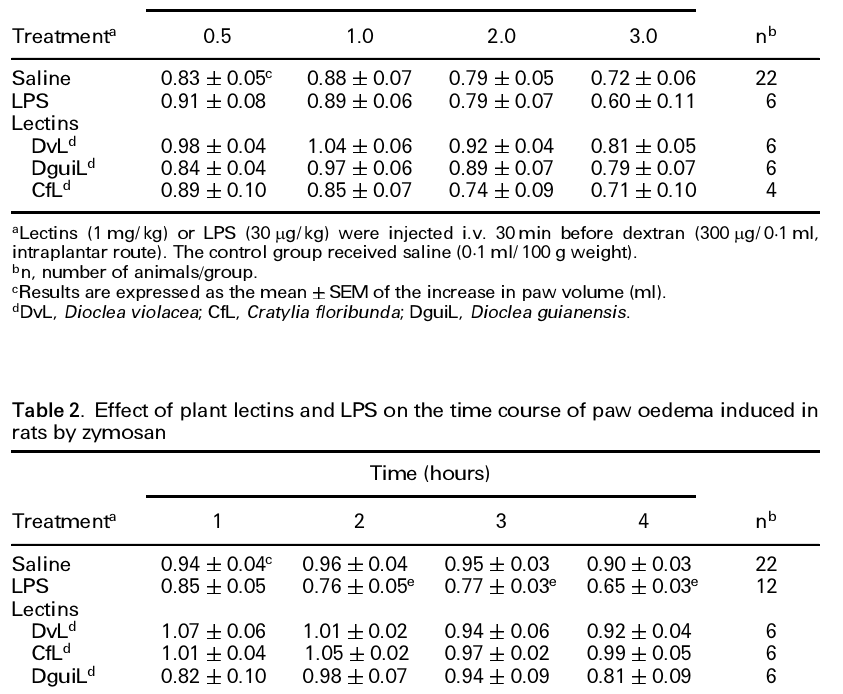
Table 1. Effect of plant lectins and LPS on the time course of paw oedema induced in rats by dextran Treatment a